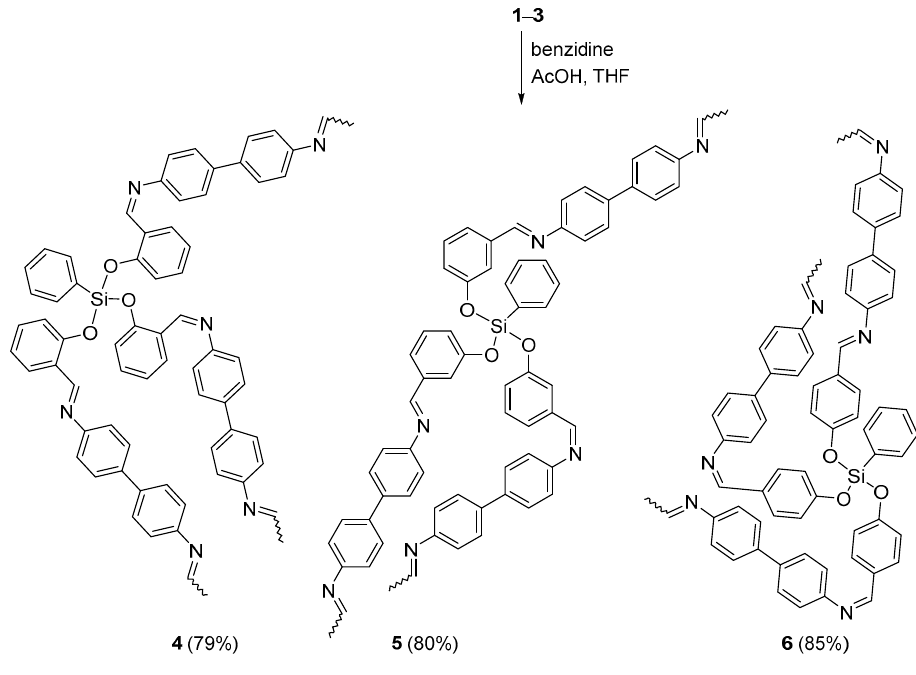
Table 2. 1 H NMR data of organosilicons 1–3 .